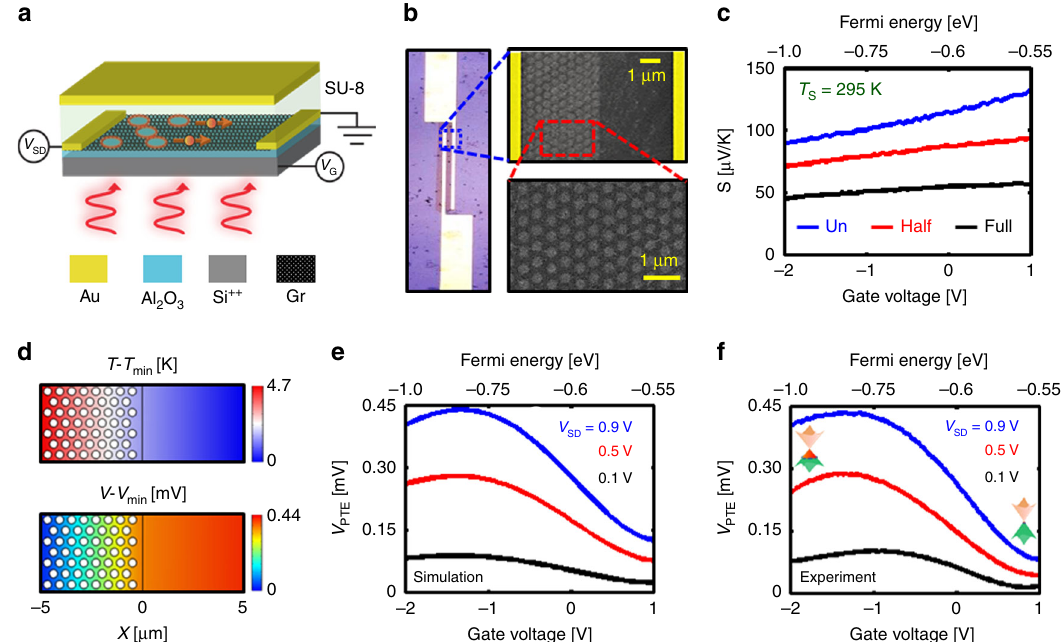
Fig. 1 Design and performance. a Schematic of the device architecture of the plasmon-assisted hot carrier generation on an asymmetrically nanopatterned graphene. Arrows on the graphene sheet show hot carrier diffusion processes. b The optical (left) and scanning electron microscope (right) images of the half-patterned graphene sample. c Seebeck coef fi cient ( S ) of the unpatterned, half-patterned and full-patterned graphene samples ( P = 600 nm and D = 400 nm) as a function of gate voltage at room temperature. d The simulated temperature (top) and potential (bottom) pro fi les of the graphene detector at E = − 0.85 eV, λ = 8.15 μ m and V = 0.9 V. The simulated, e and measured, f D.C photo-thermoelectric voltage ( V F res SD function of Fermi energy for the different bias voltages. Blue, red and black diagrams correspond to the source-drain voltages of 0.9 V, 0.5 V, and 0.1 V, respectively. (Un: unpatterned — Half: half-patterned — Full: